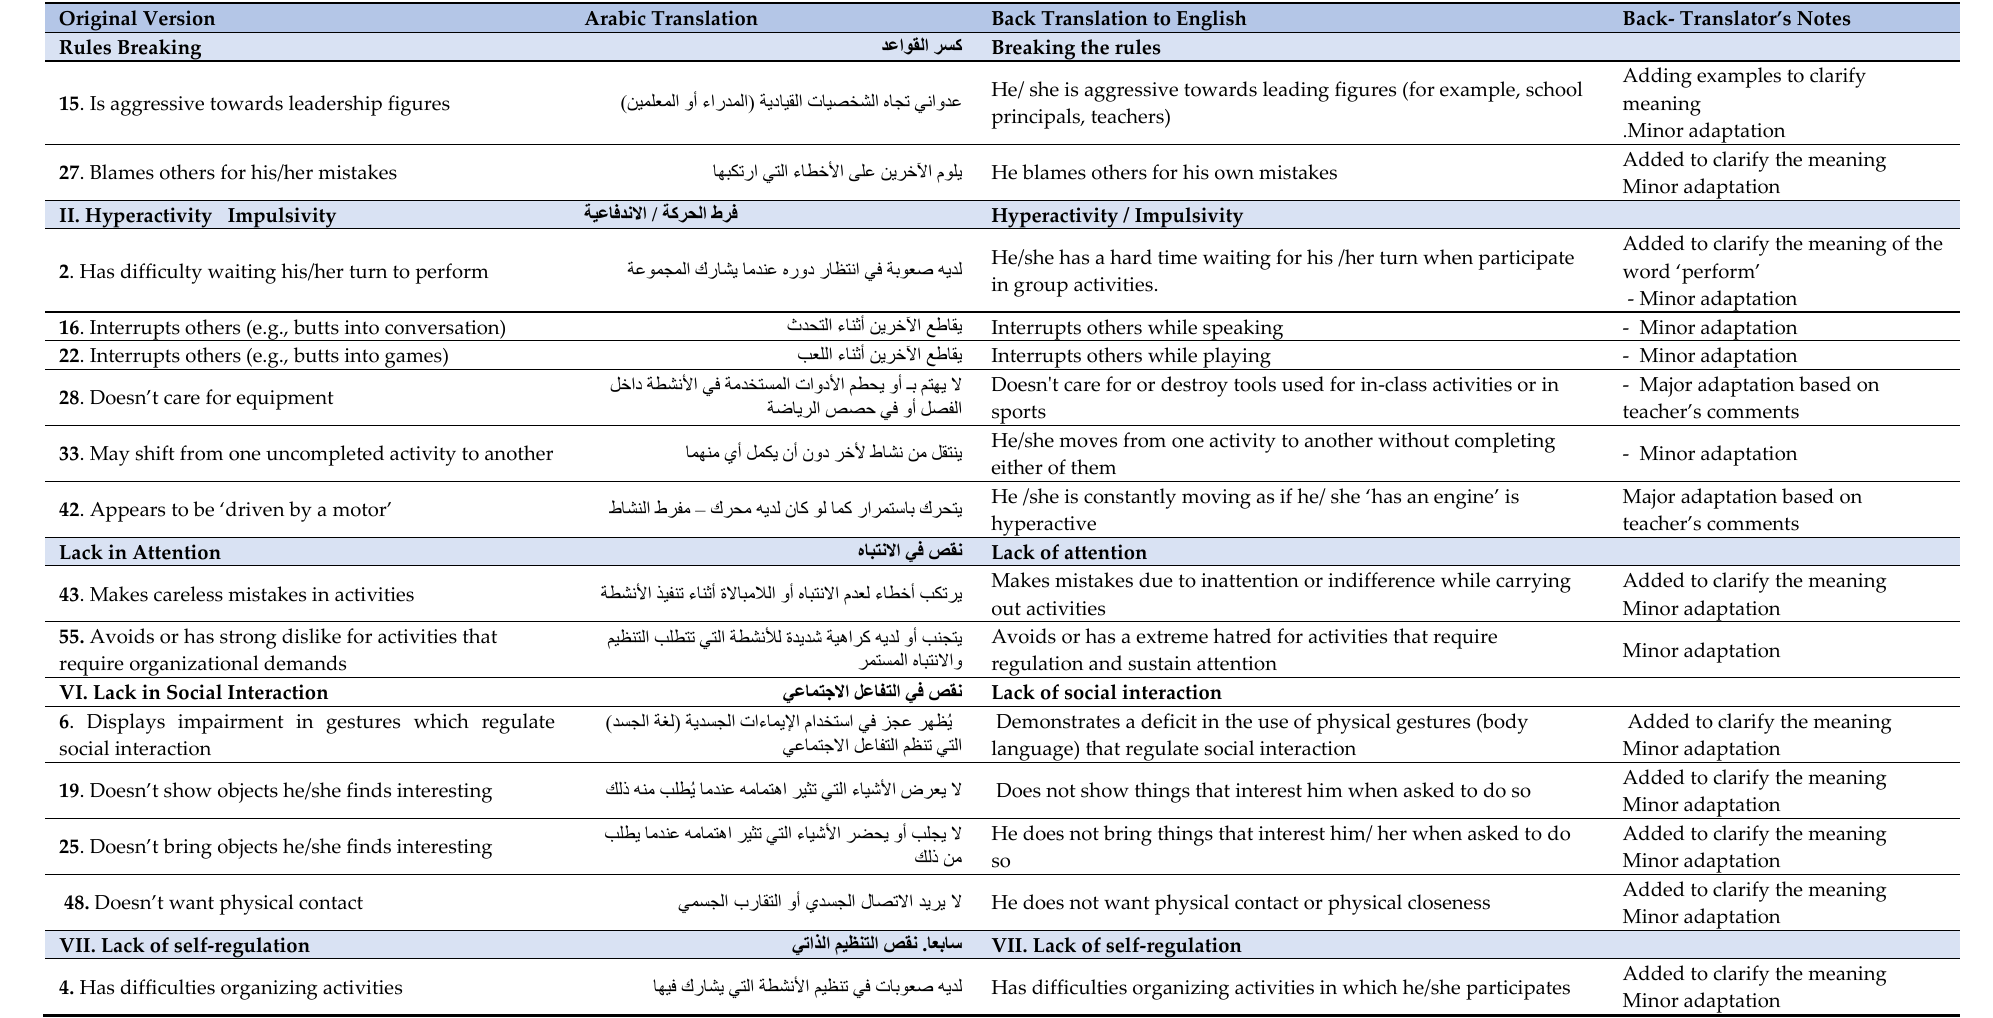
Table 2. Comparison between the original version of the MBC checklist and the translated and back-translated versions with semantic